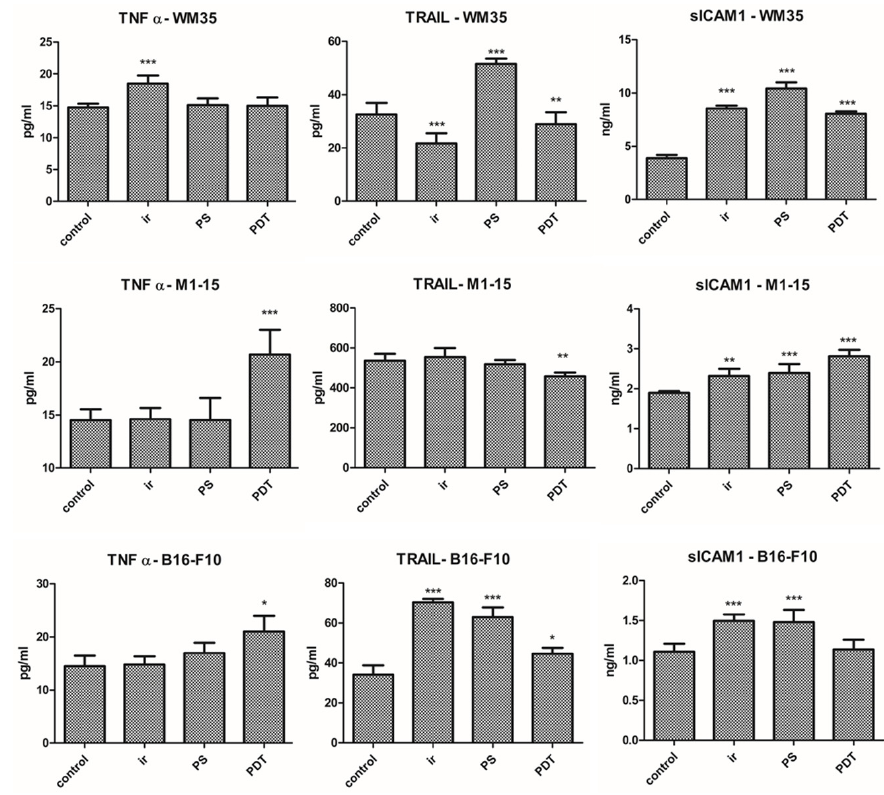
Figure 6. Inflammation. ELISA measurement of TNF- α (pg/mL), TRAIL (pg/mL), and sICAM1 (ng/mL) for each co-culture; Each bar represents mean ± standard deviation ( n = 3). * = p < 5.0 × 10 − 2 , ** = p < 1.0 × 10 − 2 , *** = p < 1.0 × 10 − 3 , compared to control. 1 = control, 2 = irradiated (100 mJ/cm 2 ), 3 = THPP (15 µg/mL), 4 = PDT (THPP 15 µg/mL and irradiation 100 mJ/cm 2 ). sICAM1 was increased by PDT in all co-cultures, significant for WM35 and M1-15 ( p ≤ 0.0033). The increased level of sICAM1 is important to further promote leukocyte adhesion by the lymphocyte function-associated antigen (LFA1) to endothelial cells in vivo [41]. This interaction between ICAM1 and LFA1 further facilitates leukocyte migration into the targeted tumor area, enhancing antitumor clearance and exposing hidden melanoma antigens to the leukocytes, a response potentiated by PDT-induced DAMPs [5,42]. 3.2.7. Angiogenesis Markers Tumor angiogenesis is responsible for tumor invasion and metastasis and therapy resistance. VEGF stimulates the formation of new branches for the tumor blood vessels, thus the inhibition of the VEGF/VEGFR pathway plays an important anti-angiogenic role [43]. HIF1 α directly activates VEGF and VEGFR-1 transcription by binding to hypoxia- response elements (HREs), leading to the expression of hypoxia-response genes. The overexpression of HIF1 α and VEGF leads to aggressive lesions and regulates endothelial and tumor cell function [44]. The contact co-culture employed is a simpler model without the elaborated 3D architecture of an in vivo tumor, but it contains interacting melanoma and endothelial cells, as encountered in a clinical scenario. Therefore, it can be used to quantify angiogenesis markers synthesized by the tumor and endothelial cells upon stimulation responsible for the growth of the tumor vasculature in vivo. HIF1 α and VEGF levels were significantly decreased by PDT in all co-cultures (Figure 7), p < 0.0001. This is consistent with other reports on the co-cultures of HUVECs with human bladder carcinoma or glioma cells. In a prostate cancer model, PDT destroyed the barrier function of endothelial cells. Some tumor cell lines produce angiogenic factors that induce HUVEC proliferation and subsequently increase their sensitivity to PDT [45]. On an in vivo mouse melanoma model, the efficiency of vascular-targeted exceeded cellular-targeted PDT